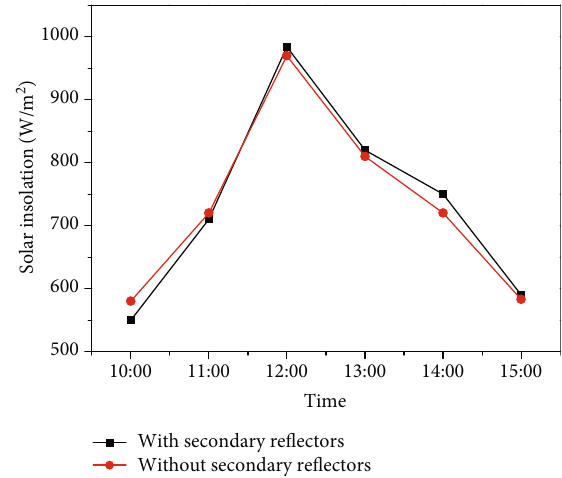
Figure 8: Solar insolation with and without secondary re fl ectors.